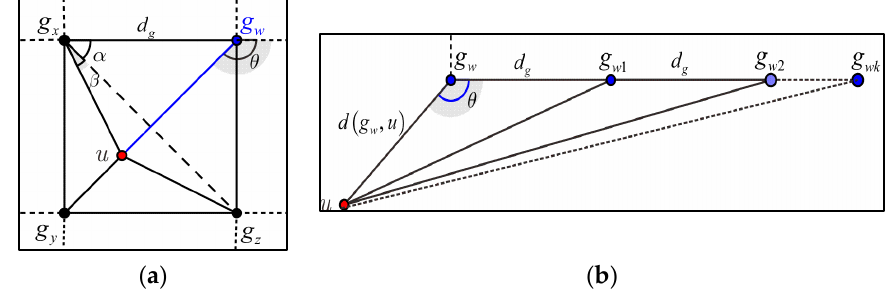
Figure 4. Derivation of DNV by the RSSI data from the L RSS field of LCQ. ( a ) Deciding node u ’s position in a single grid using RSSI of the nearest three deployment points; and ( b ) derivation of the distances between node u and the deployment points using the group deployment knowledge.